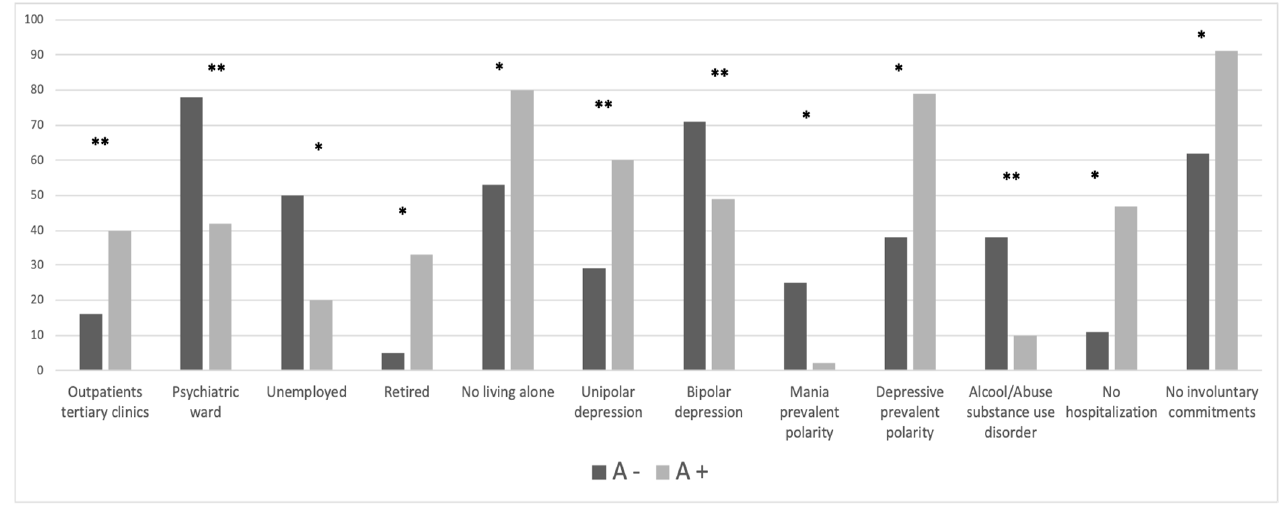
Figure 1. Comparison of sociodemographic and clinical features between subgroups. Notes: A − : negative adherence to treatment, A+: positive adherence to treatment. ** p < 0.005 * p < 0.05.